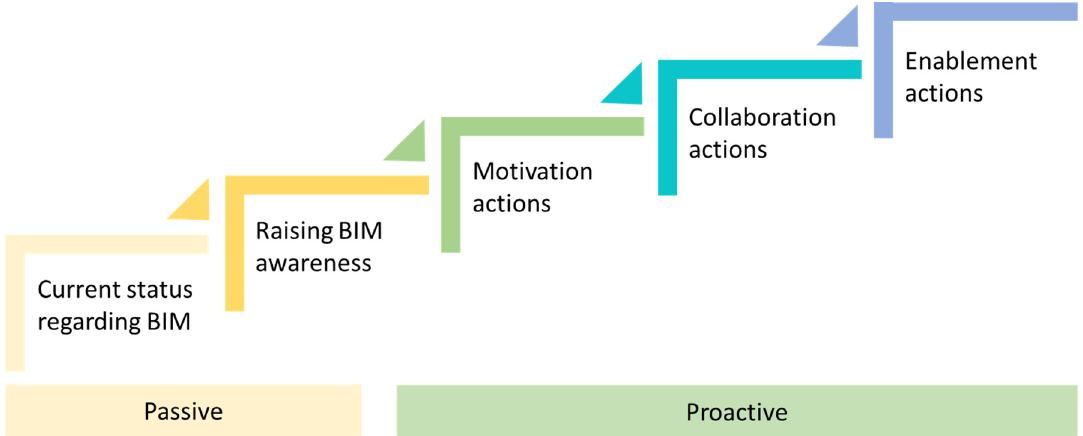
Figure 4. Proposed types of action toward BIM adoption in the National BIM Roadmap.